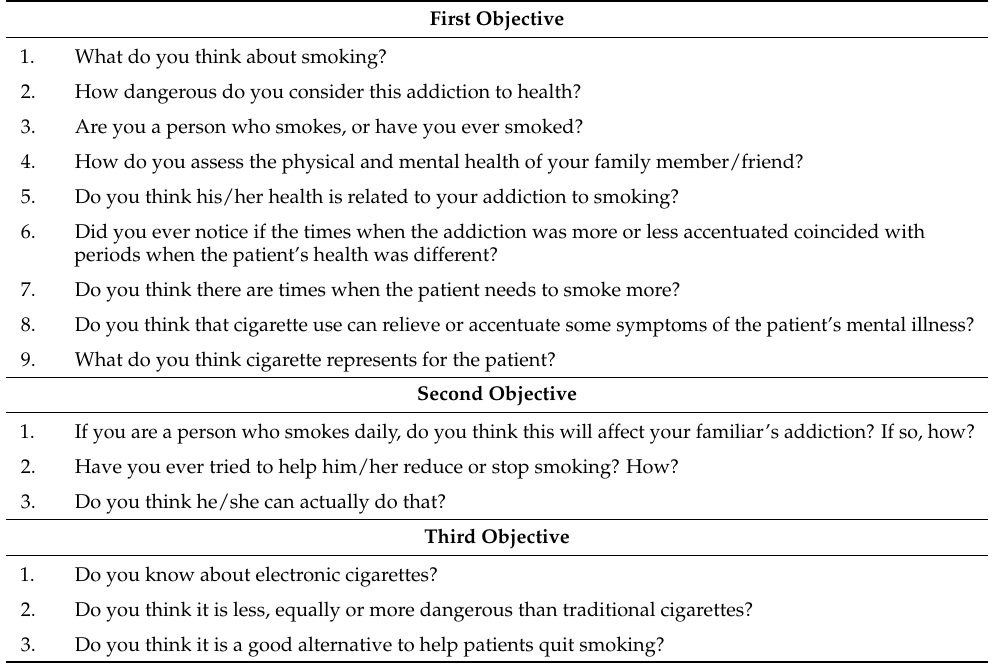
Table 1. Questions for research